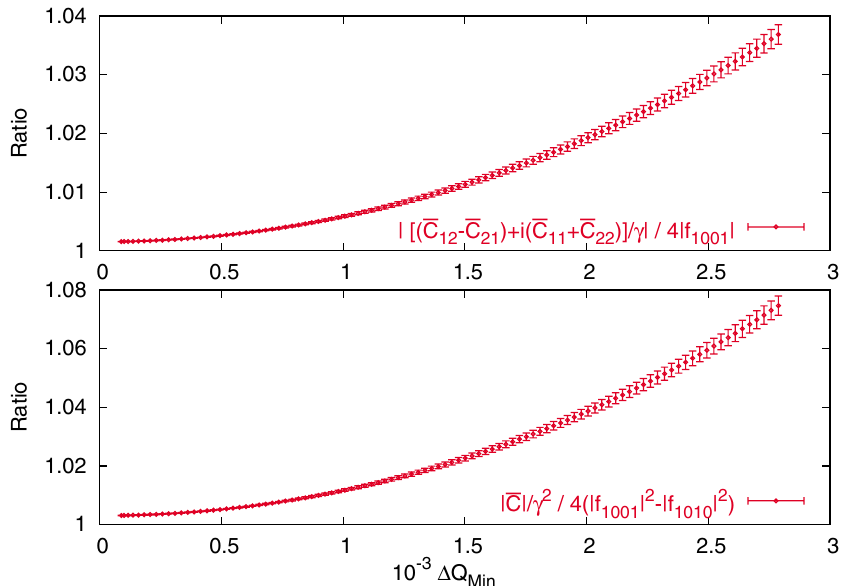
(cid:2) C (cid:7) (cid:5) i (cid:6) C (cid:5) C (cid:7)(cid:12) =(cid:20) j and 4 j f j . Bottom: Mean of the ratio of j C j =(cid:20) 2 and 12 21 11 22 1001 (cid:3) 17 : 232 y =(cid:20) , one relies 12